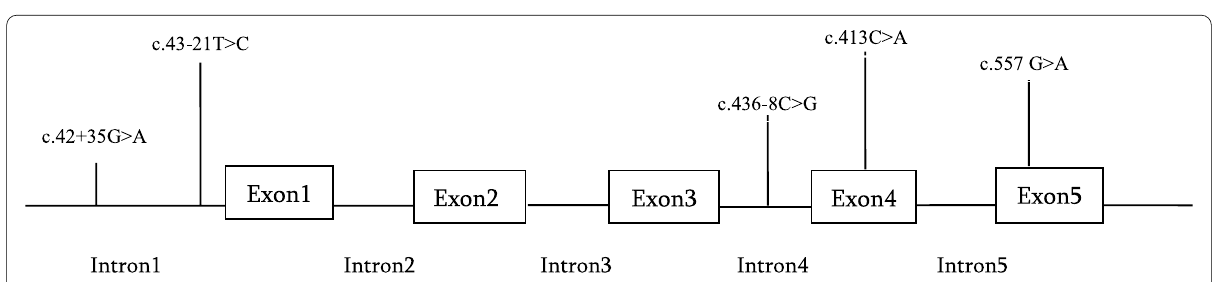
35G>A and c.43‑21T>C in intron 1, c.436‑8C>G in +